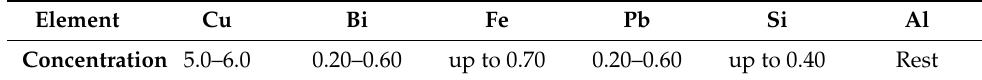
Table 1. Chemical composition of the EN AW 2011 aluminium alloy/wt.% [21]. Element Cu Bi Fe Pb Si Al Concentration 5.0–6.0 0.20–0.60 up to 0.70 up to 0.40